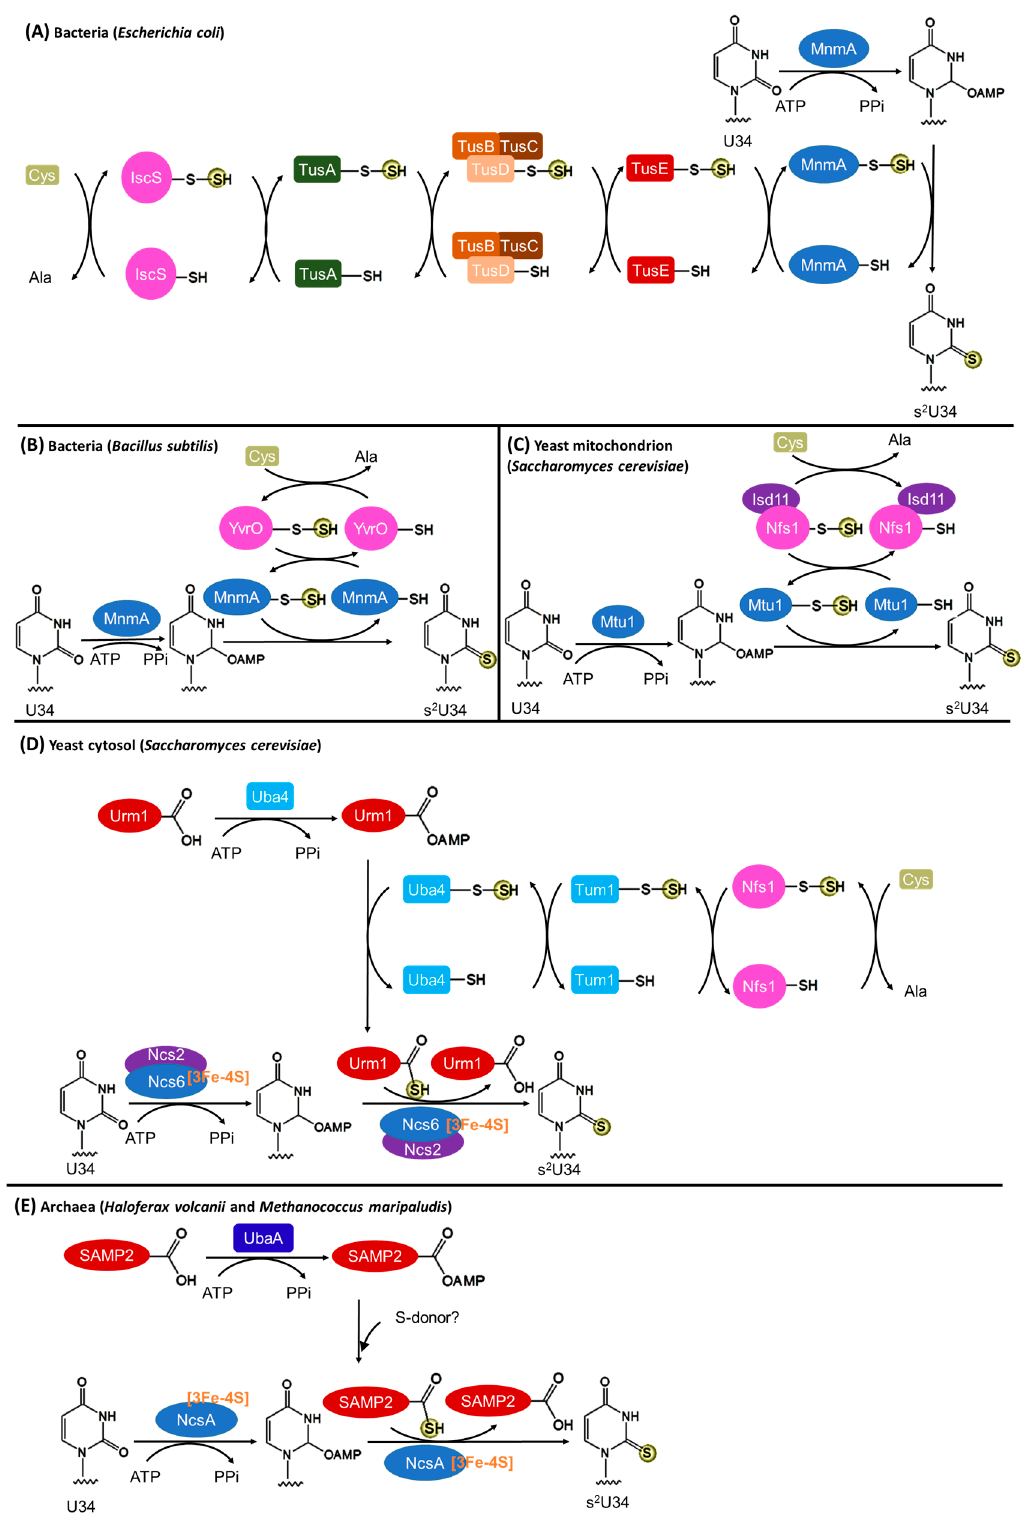
Figure 4. The biosynthetic pathways of tRNA s 2 U34 in all domains of life. ( A ) In E. coli , the pathway is Fe–S cluster independent, and the sulfur transfer involves persulfide enzyme adducts; ( B ) B. subtilis uses a truncated pathway that is Fe–S cluster independent; ( C ) The yeast mitochondrial pathway may resemble the B. subtilis pathway; ( D ) The yeast cytosolic pathway is Fe–S cluster dependent, and the sulfur transfer involves persulfide and thiocarboxylate enzyme adducts; ( E ) The archaeal pathway may resemble the yeast cytosolic